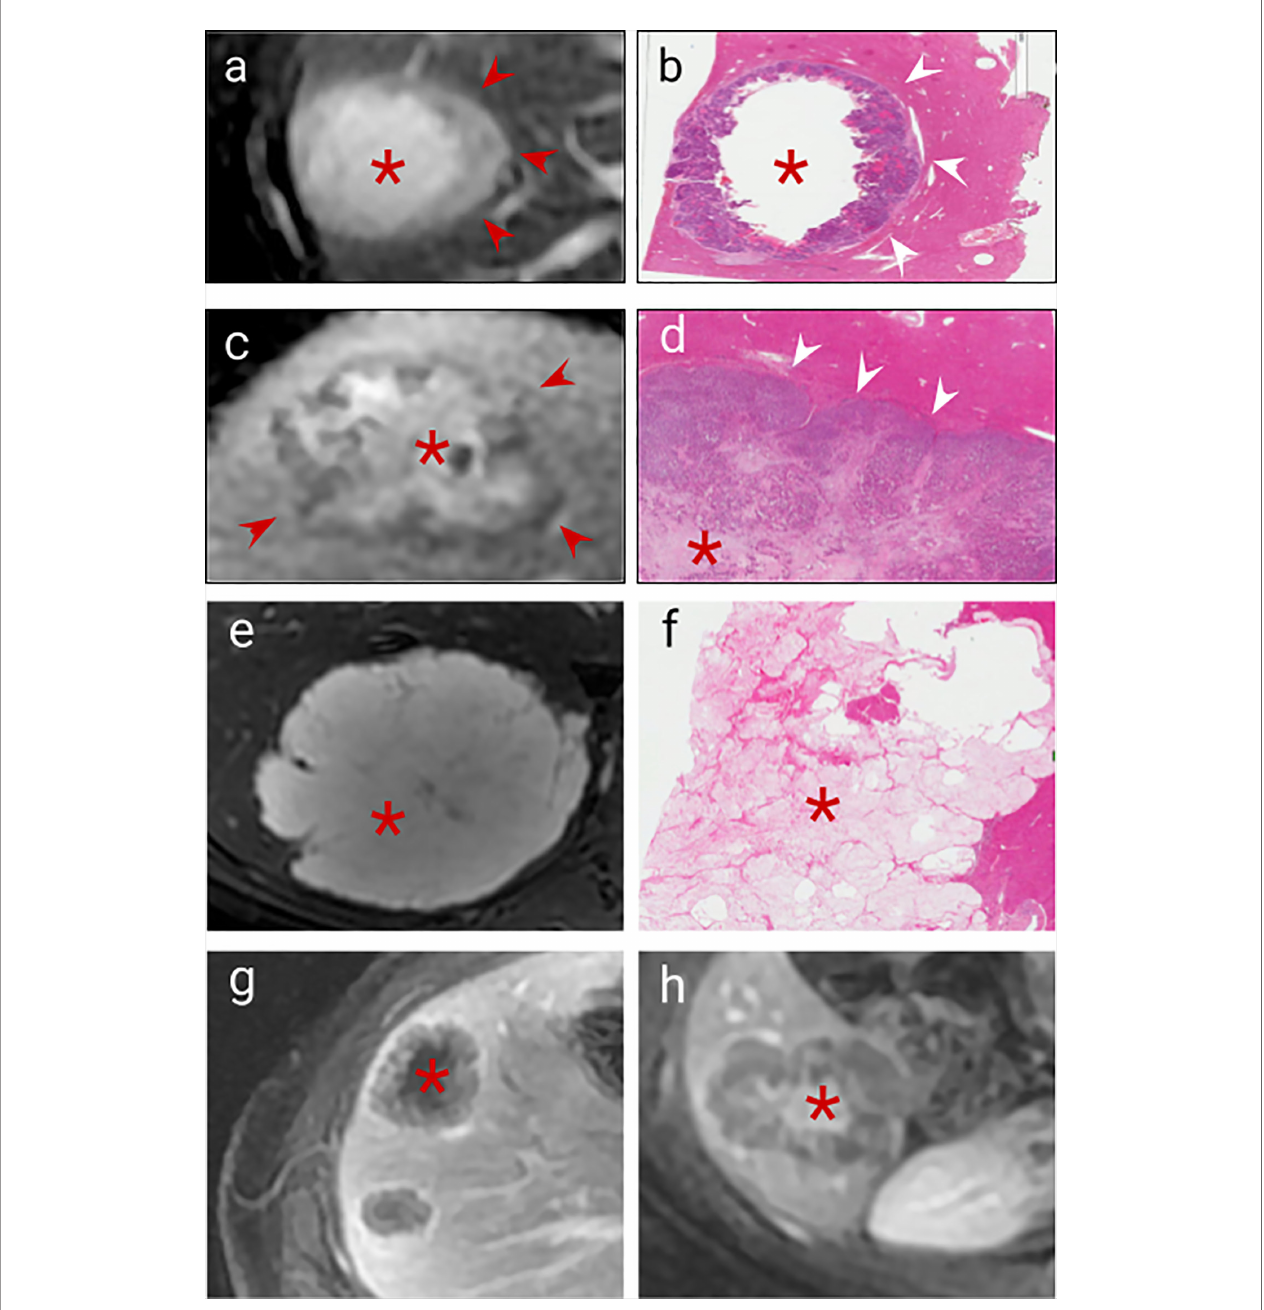
FIGURE 3 | Imaging correlates of internal tumour composition. (A) . T2 weighted non-enhanced MRI of a lesion displaying moderately high central T2 signal suggestive of central necrosis (asterisk) and surrounding viable tumour which is higher signal than normal liver (arrows), (B) . H&E staining of this CRLM con fi rms peripheral viable tumour (arrows) with central liquefaction of the metastasis indicating classical Garland necrosis (asterisk), (C) . Delayed phase gadolinium-enhanced T1 fat saturated MRI showing avid central delayed enhancement indicating fi brosis (asterisk) with surrounding viable tumour cells which enhance less than normal liver (arrows), (D) . H&E staining of this CRLM con fi rming central fi brosis within the lesion (asteriks) and peripheral viable tumour cells (arrows), (E) . T2 weighted sequence demonstrated homogenous high signal mucin (asterisk) (F) . H&E staining con fi rming mucin containing metastasis (asterisk) (G) . Delayed phase gadolinium- enhanced T1 fat saturated MRI showing centrally necrotic lesions (no delayed central enhancement, asteriks), (H) . Delayed phase Gadolinium enhanced T1 fat saturated MRI showing late central enhancement indicating a centrally fi brotic lesion (asterisk) which contrasts with (G) (central necrosis).